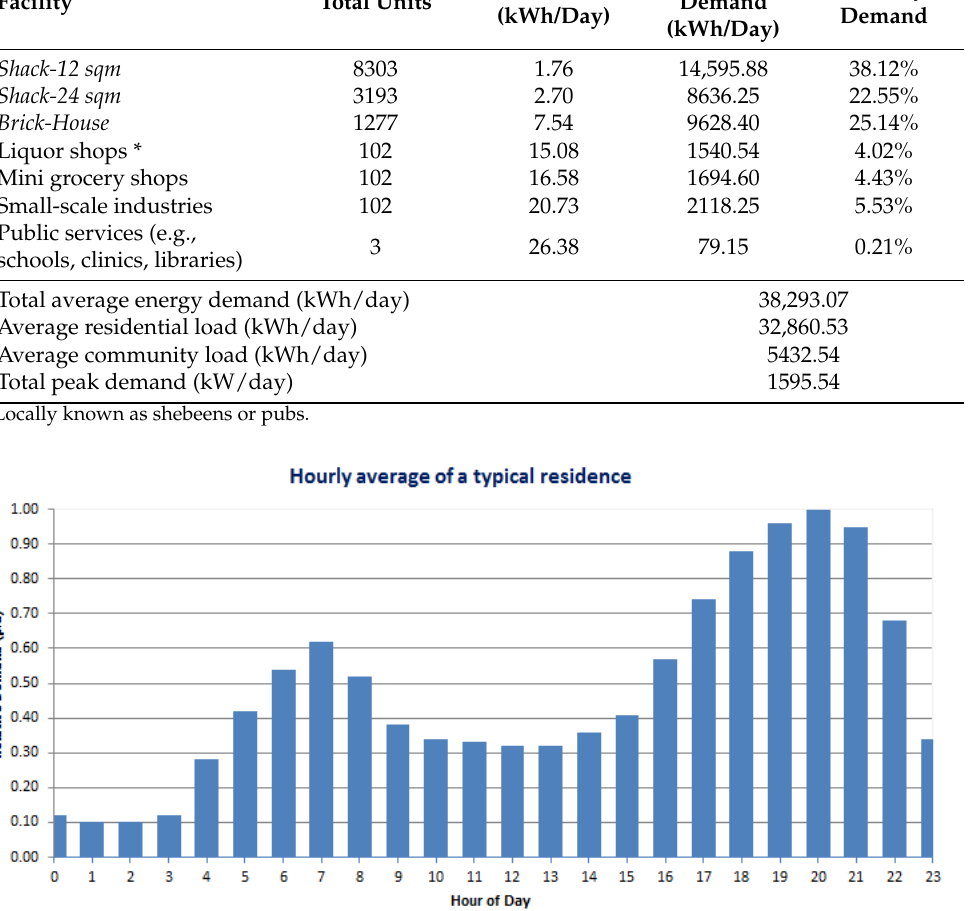
Table 5. Estimated daily load profile for the Havana settlement.